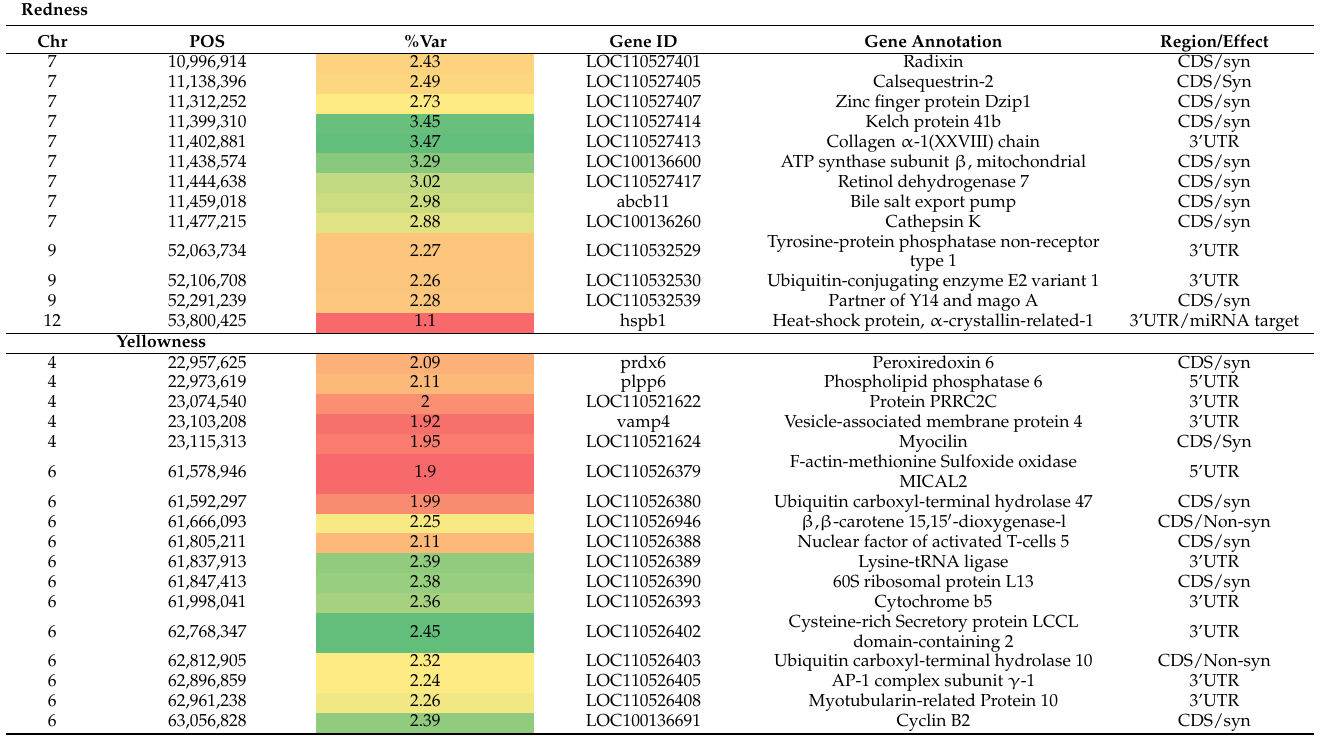
Table 2. Selected SNP markers within 50 SNPs’ genomic sliding windows, explaining at least 1% of the additive genetic variance for fillet redness and yellowness traits.